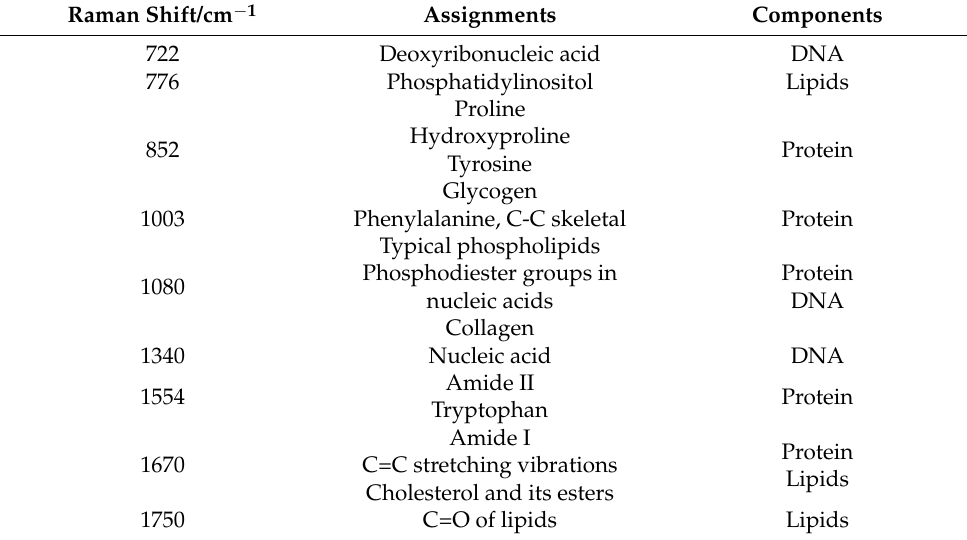
Table 1. Raman spectral interpretations